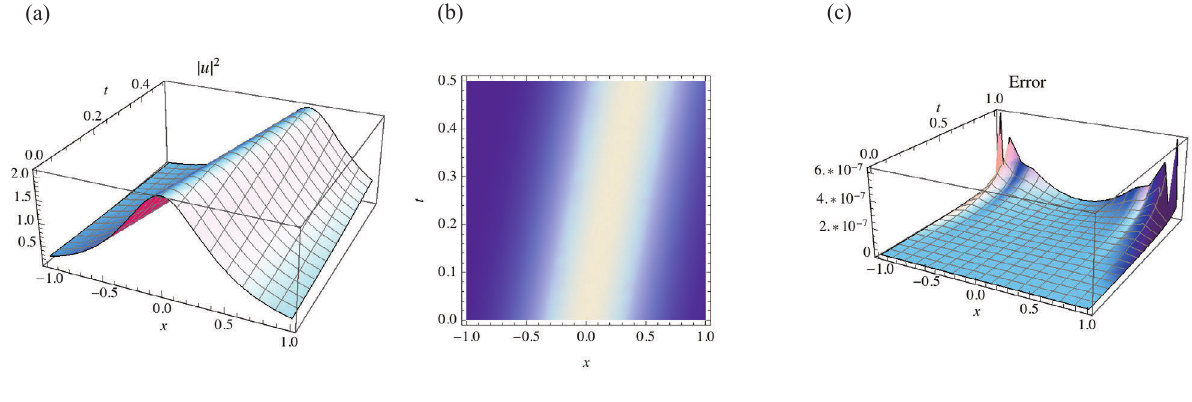
Fig. 4. Graphical representation of the results of example 4: (a) 3D bright soliton, (b) 2D density contour and (c) Absolute error with N = 14 iteration steps.